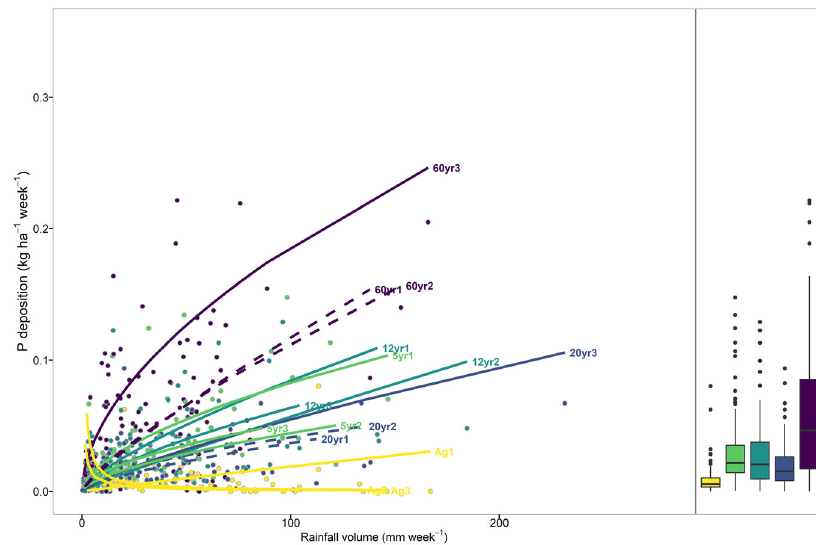
Fig. 3 Weekly rainfall amount (open- fi eld rainfall volume for agricultural fi elds, throughfall volumes for the forest stages) versus weekly phosphorus (P) deposition, in agricultural fi eld (Ag), 5- (5 yrs), 12- (12 yrs), 20- (20 yrs), and 60-year-old forest (60 yrs). Solid lines show signi fi cant log – log fi ts via standardized major axis regression, while dashed lines indicate insigni fi cant regressions ( P -value > 0.1). Boxplots show the median, the 25th and 75th percentile and the 1.5 interquartile range spread for the weekly P deposition loads. Points in represent the individual weekly measurements of composite samples ( n = 8) per plot for rainfall volume and P deposition.